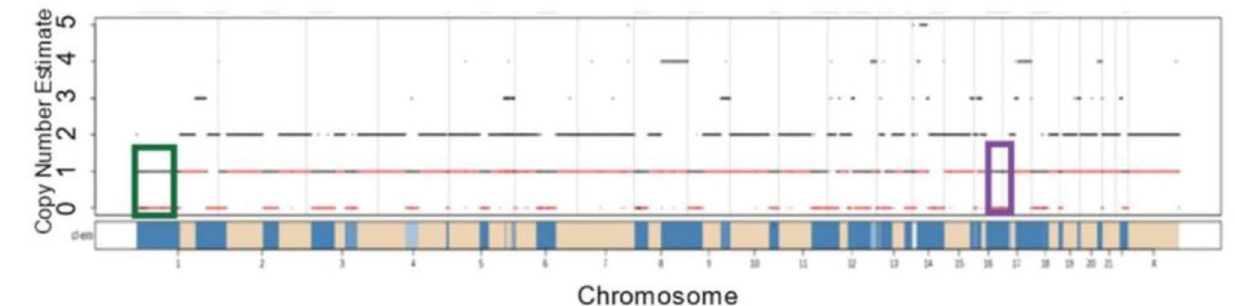
Figure 3. Copy number estimates from FACETS for Patient 1. A decrease in copy number along part of Chromosome 1 is shown in the green box. This green box includes YTHDF2 , a gene that is partially deleted by a mobile element associated event. The purple box is highlighting a decrease in copy number along Chromosome 17. Included in this purple box is MAP2K4, a gene that is interrupted by a translocation event associated with mobile elements. The black lines in the figure represent the total copy number, while the red lines show the minor copy number for each